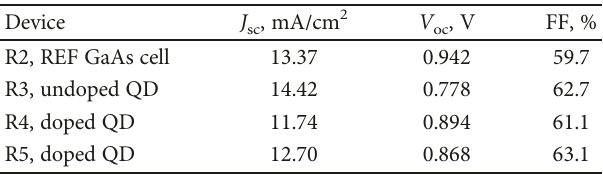
Figure 3: Current density versus voltage characteristics measured under one-sun illumination (AM 1.5G) for the reference GaAs bulk cell (R2), undoped QDSC (R3), and two-doped (14 e/dot) QDSC with interdot spacing of about 20nm (R4) and 25nm (R5). Table 1: Photovoltaic parameters extracted from the measured J − V characteristics in Figure